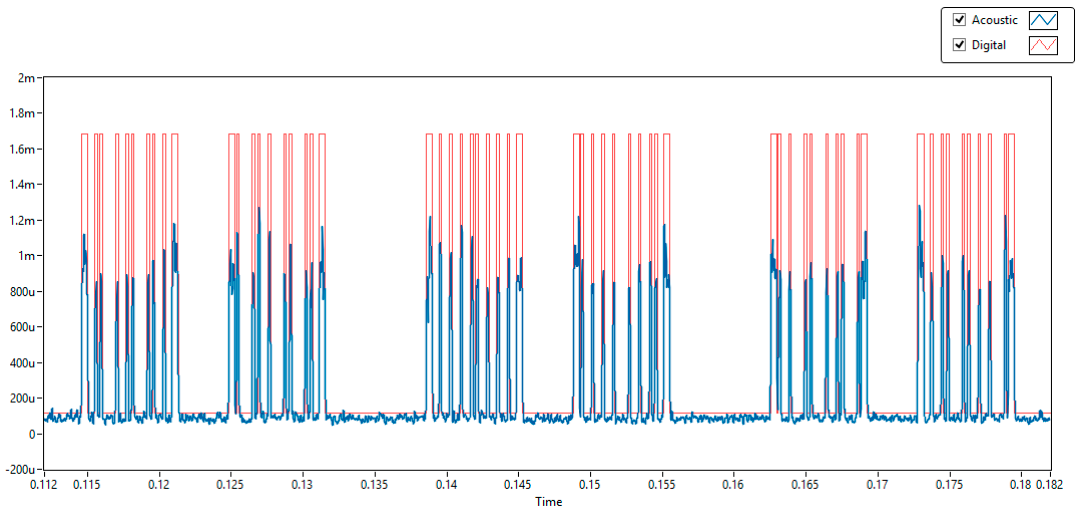
Figure 14. Identification of three different information bytes and their corresponding HASH bytes.